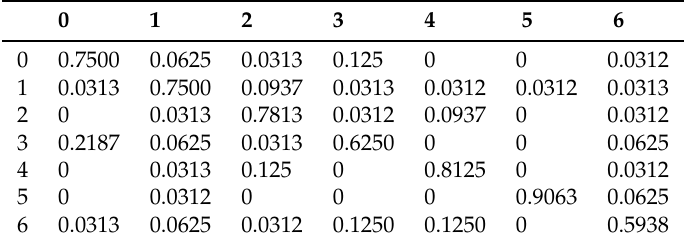
Table 7. Classification confusion matrix (ratio) for DataSet1 by using CNN